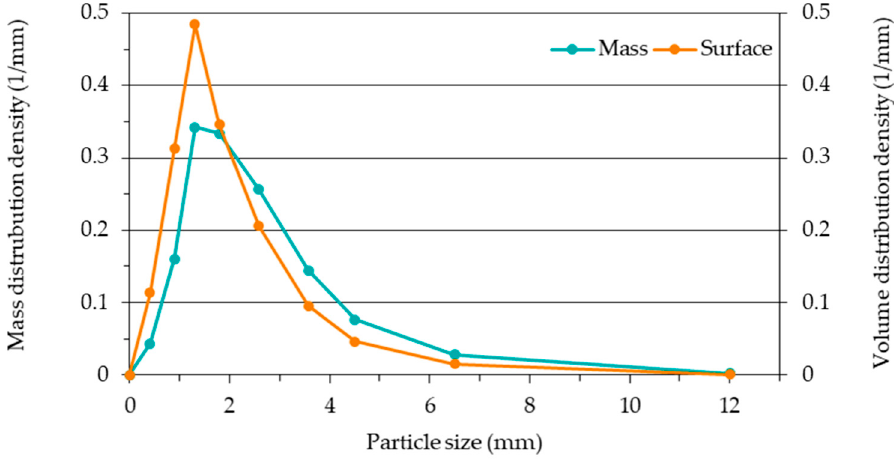
Figure 13. Mass and surface distribution density for particles, according to their size, of Particle Material 1. The data used to create Figure 13 can be found in Table 6. Table 6. Data used to create Figure 13.